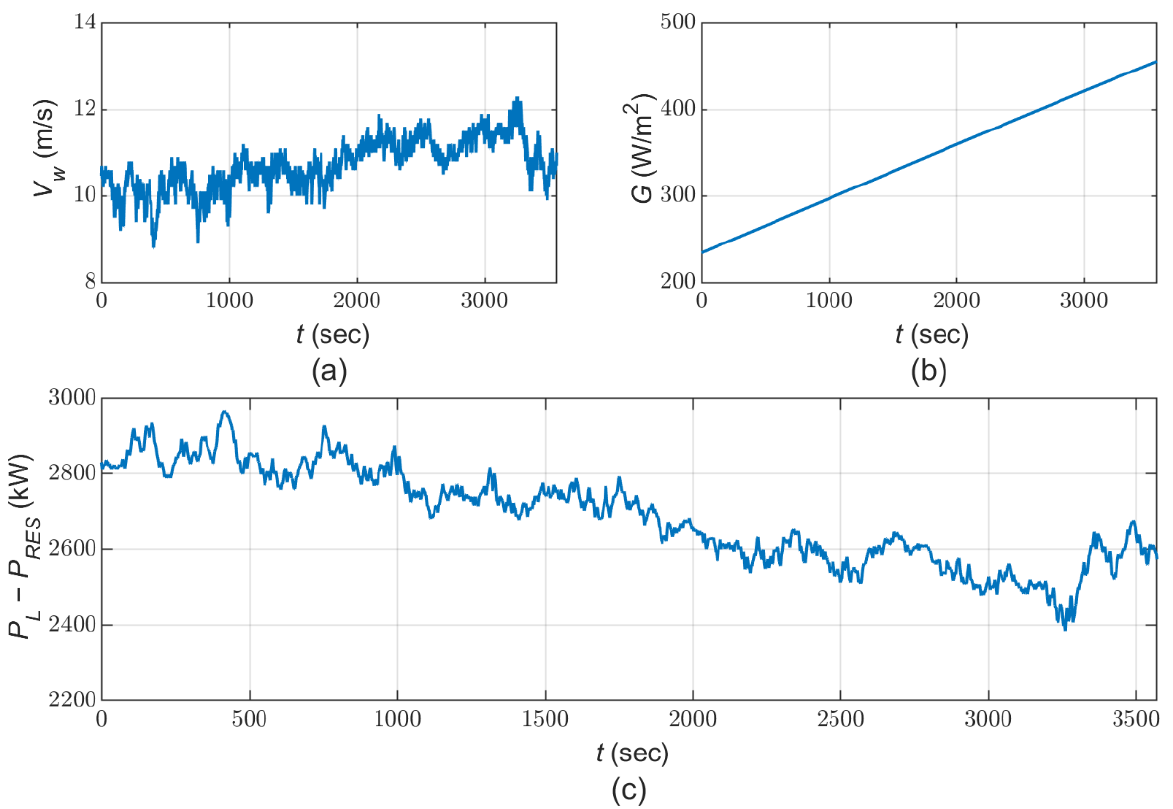
Figure 7. ( a ) Wind speed, ( b ) solar irradiation and ( c ) residual load (load − renewable energy source generation) during the 1 h simulation interval.